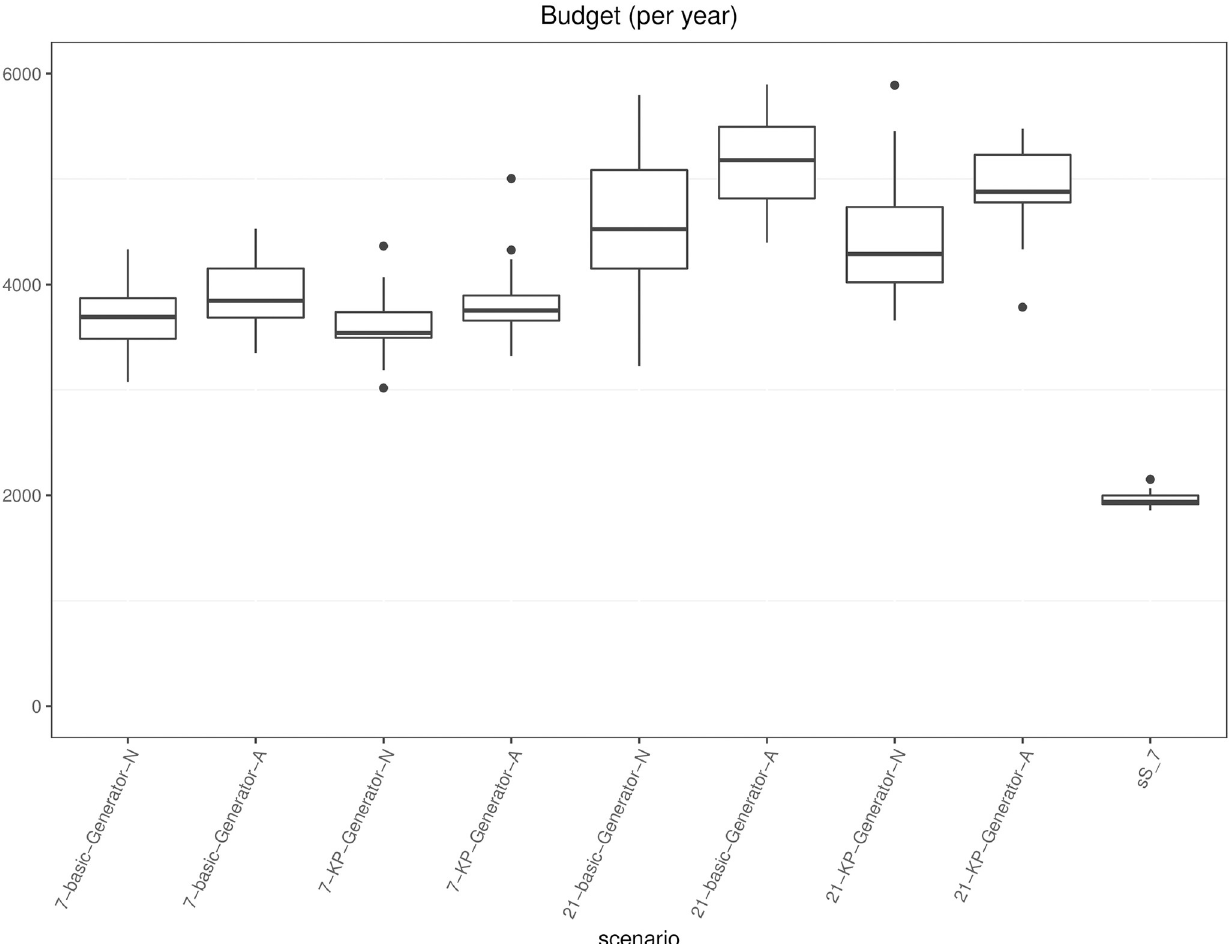
Fig 7. Stock value. For each variant, the average value of drugs in stock on a day, over the year ( € ). Each boxplot shows the results of 30 instances. Policy names refer to the ω , safety stock option (basic or knapsack), demand forecasting option (Generator), and aware (A) or not aware (N) variant. sS_7 refers to the periodic